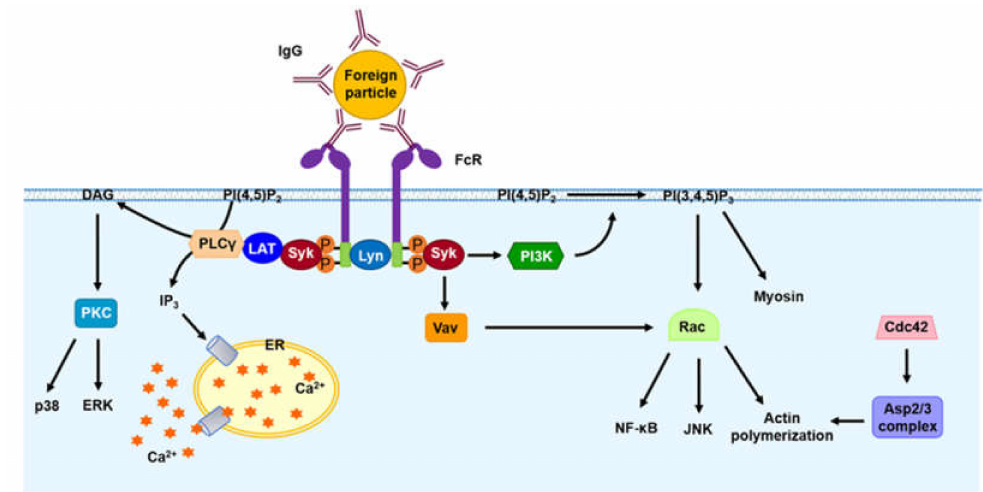
Figure 1. Fc receptor (FcR)-mediated signaling for phagocytosis. Engagement between FcR and the IgG immune complex induces FcR crosslinking and phosphorylation of ITAM on the cytoplasmic tail of FcR by SFKs, such as Lyn, Lck and Hck. The phosphorylation of ITAM is responsible for the recruitment and phosphorylation of Syk. Phosphorylated Syk triggers the conversion of PI(4,5)P 2 to PI(3,4,5)P 3 through PI3K. PI(3,4,5)P 3 regulates the activation of Rac and myosin. Vav is activated by Syk to further activate Rac. Rac activates the NF- κ B- and JNK-mediated signaling pathways. Rac and Cdc42 contribute to actin polymerization. Phosphorylated Syk also generates DAG and IP3 from PI(4,5)P 2 . DAG induces PKC-mediated activation of p38 and ERK signaling. IP 3 triggers the release of Ca 2 + from the ER to the